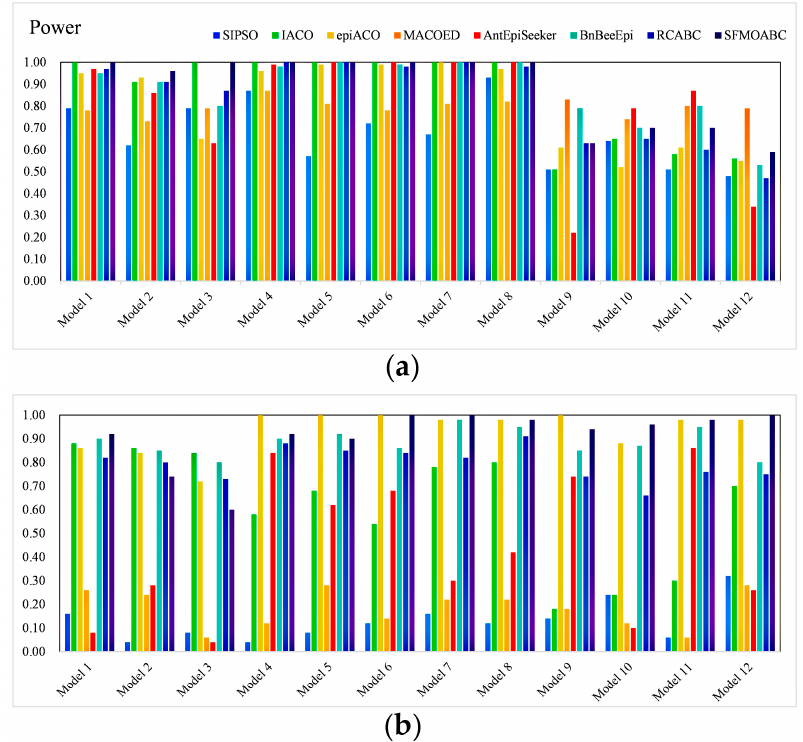
Figure 3. Power of methods based on the swarm intelligence algorithm: ( a ) Power on the small-scale datasets; ( b ) Power on the large-scale datasets.